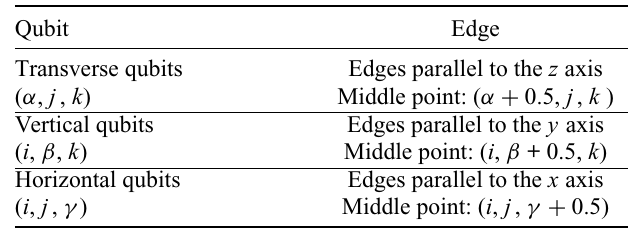
TABLE V. Correspondence between qubits in C 1 and edges of the lattice.